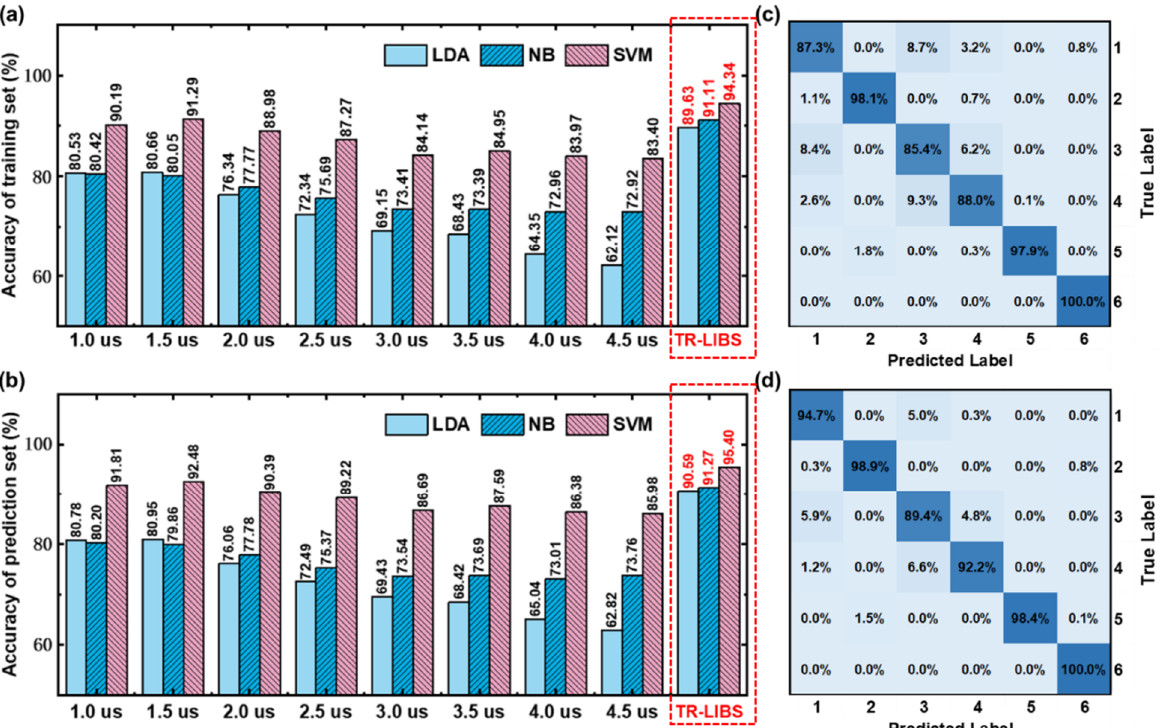
Figure 3. ( a ) Training set and ( b ) test set results of LDA, NB and SVM models based on LIBS spectra and time-resolved spectra, and the test set confusion matrix of SVM models based on ( c ) LIBS spectra under 1.5 μs and ( d ) time-resolved spectra.